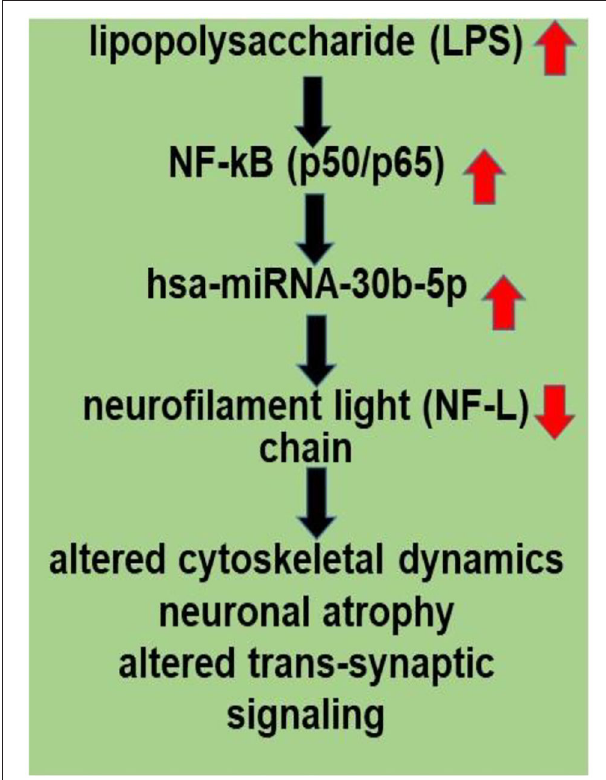
FIGURE 2 | LPS, present in brain cells affected with AD, has an inhibitory effect on NF-L expression; a human microbiome-derived lipopolysaccharide (LPS)-NF-kB-miRNA-30b-NF-L pathological signaling pathway may be in part responsible for driving altered cytoskeletal dynamics, neuronal atrophy and altered trans-synaptic signaling in stressed human neuronal-glial (HNG) cells in primary culture and in Alzheimer’s disease (AD) brain. LPSs are neurotoxic glycolipids derived from the outer cell wall of non-capsulated Gram-negative bacteria; normally they contribute to the integrity of the outer cell wall membrane and protect the cell against the action of bile salts and lipophilic antibiotics ( 50, 52, 53). Both microbial infection and LPS are strong inducers of NF-kB signaling in neurons and other human cell types. miRNA-30b is under transcriptional control by NF-kB, and the neuron-specific NF-L chain mRNA-3’-UTR is a target for miRNA-30b. Other miRNAs may be involved (see Supplementary File 1 ). Disruption and insufficiency of NF-L abundance within the neuron are in part responsible for disturbances in neuronal cytoarchitecture, atrophy, and synaptic aberrations as is observed in stressed human brain cells and in AD-affected